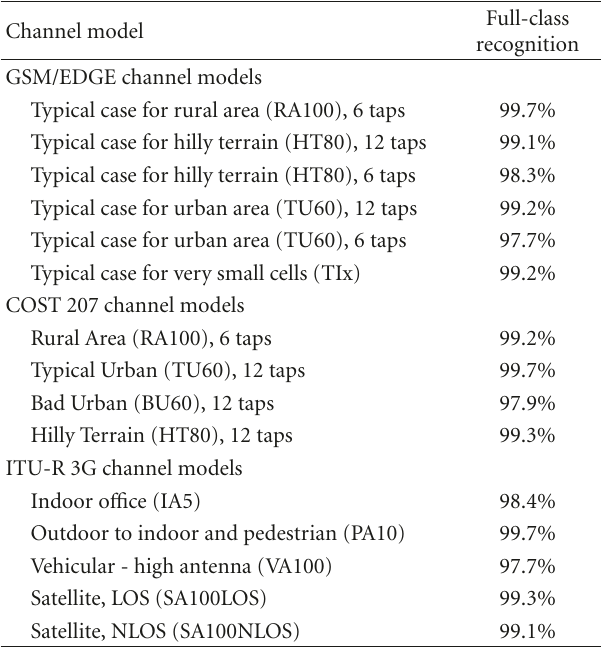
Table 10: Confusion Matrix at SNR =